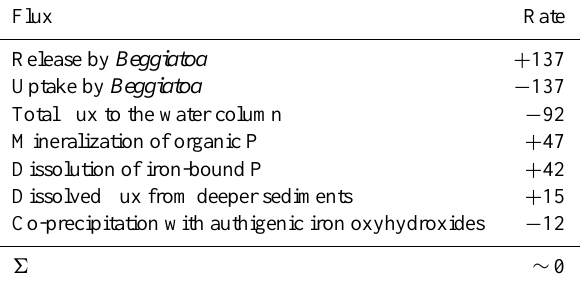
Table 4. Yearly integrated benthic sources and sinks of phosphate for the upper 40cm in Boknis Eck (mmolm − 2 yr − 1 ) listed from largest to smallest. Sources are positive and sinks are negative. Val- ues have been rounded to the nearest